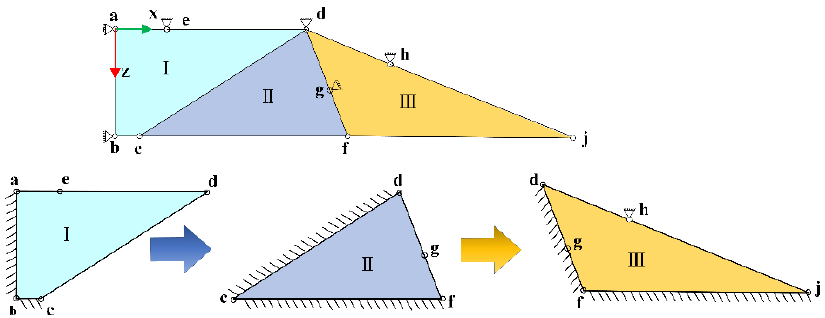
Figure 10. The error propagation of the polycyclic closed chain structure.